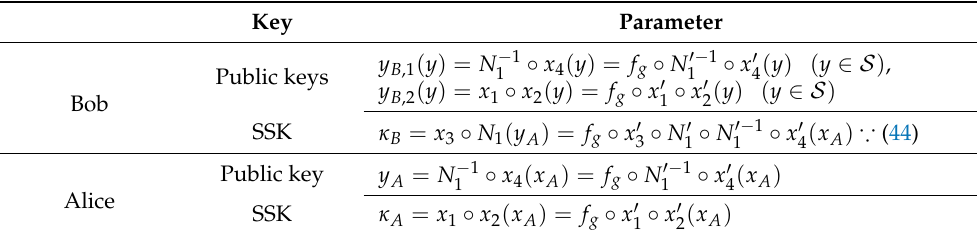
Table 4. Public keys and SSK of Alice and Bob for SAPKA f